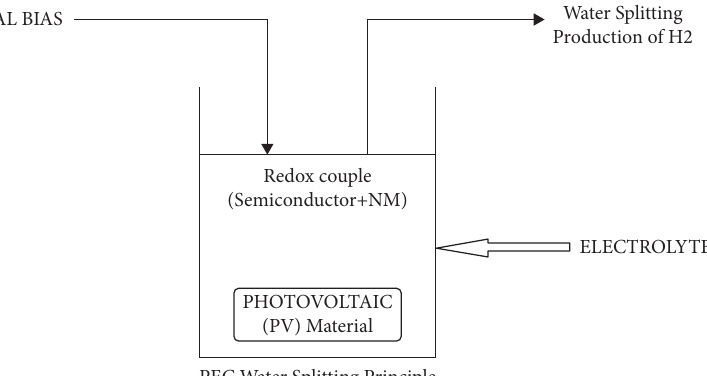
Figure 21: Principle by which water splitting takes